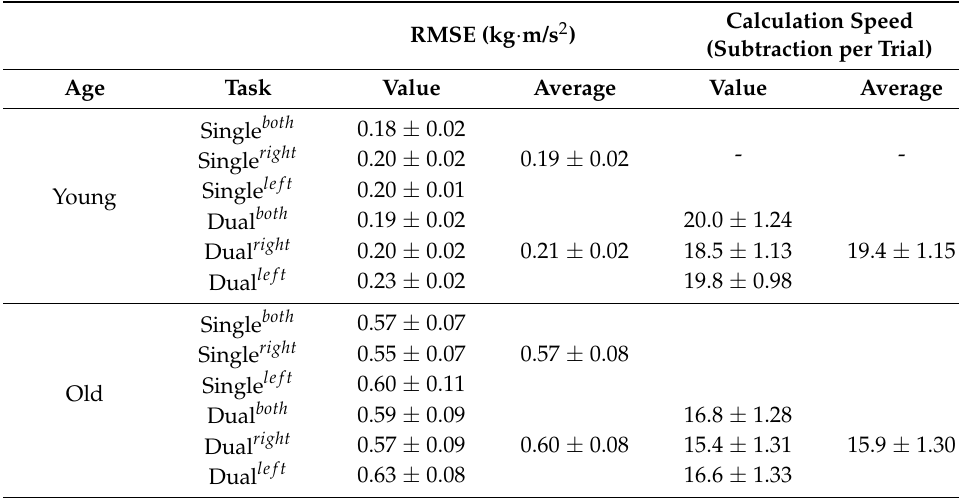
Table 1. RMSE of the Force Control and Speed of Mental Arithmetic